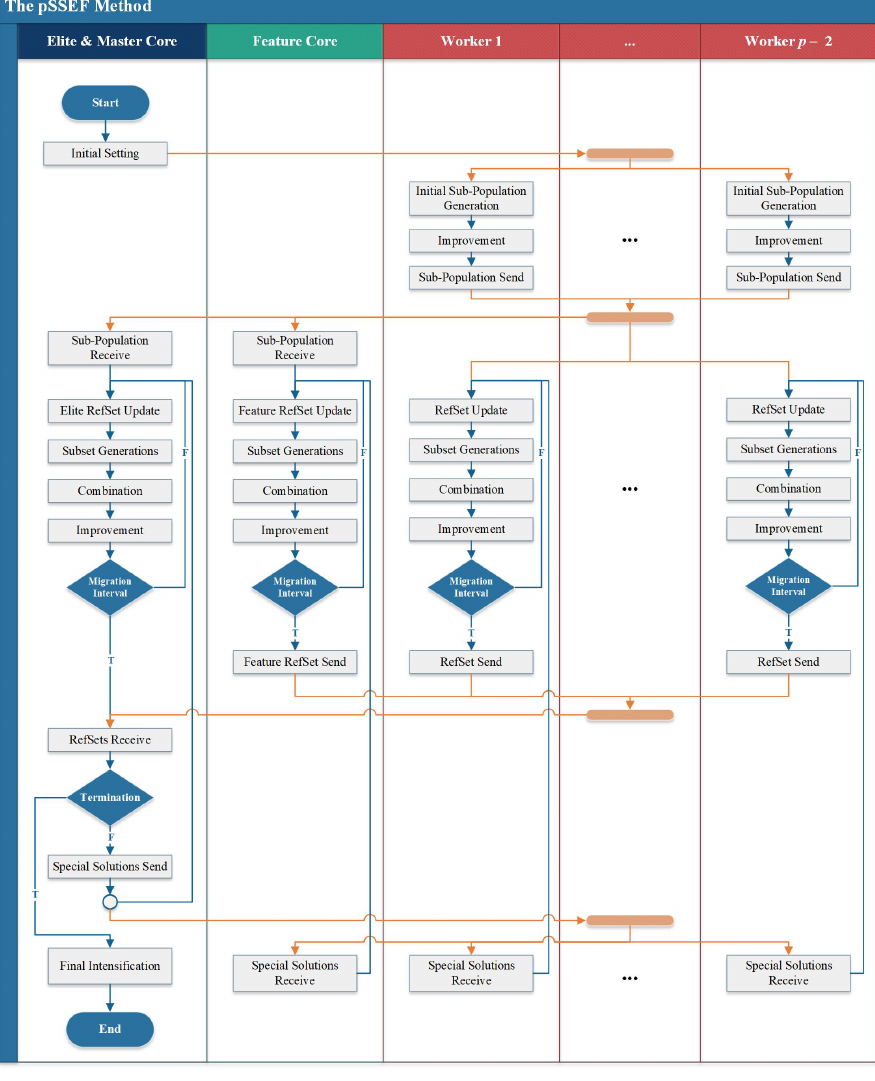
Figure 3. The pSSEF